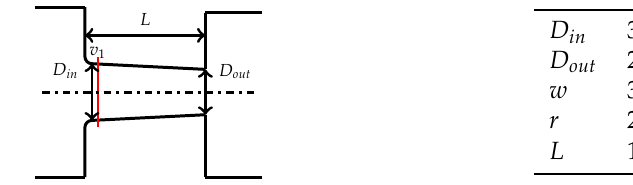
Figure 19. Reference geometry for the test case simulated.